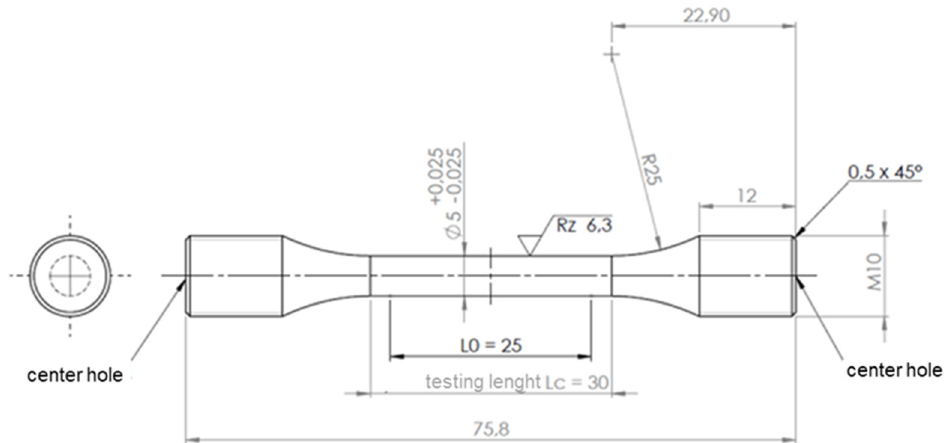
Figure 7. Conventional tensile test specimen geometry in accordance with DIN EN ISO 6892 [39] .